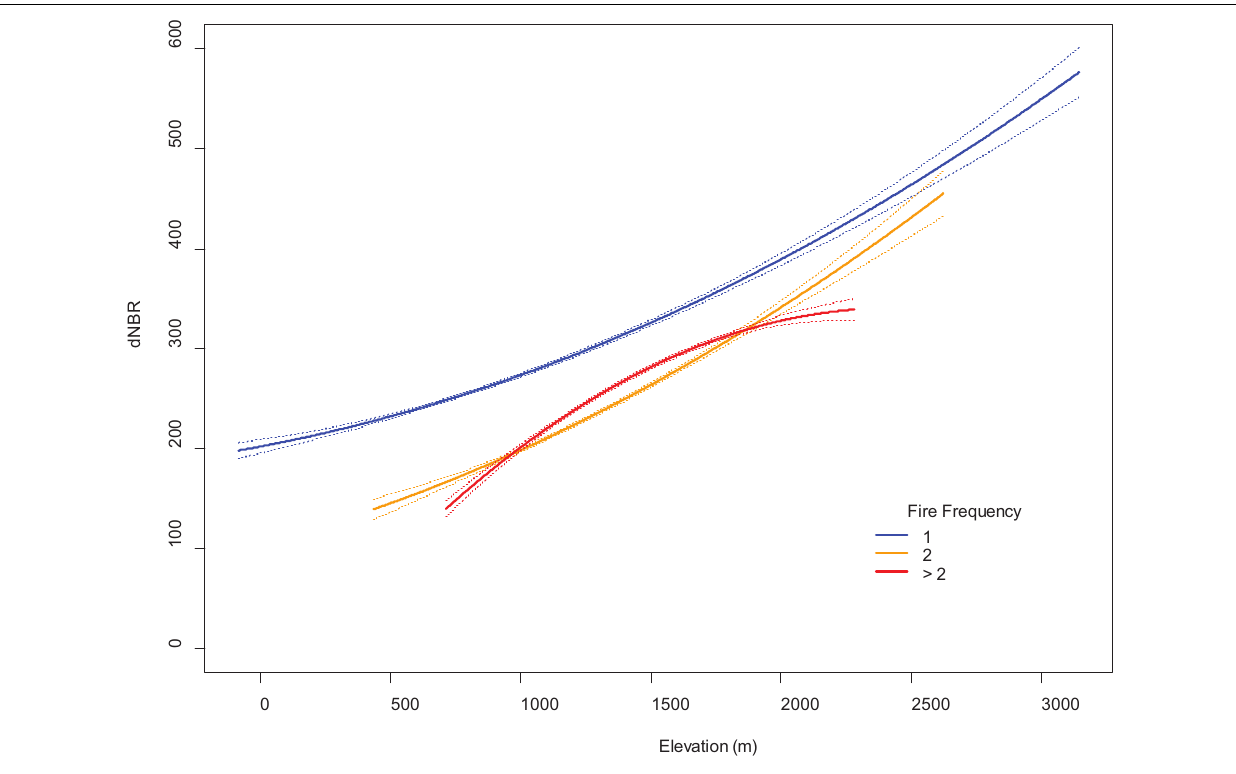
FIGURE 11 | Relationship of predicted values ( ± 95% CI) of burn severity (difference normalized burn ratio; dNBR) and fire frequency (number of times burned from 1972 to 2010) along an elevation gradient in the Mojave Desert of North America. Estimates were derived by ordinary least-squares regression from 1,000 randomly selected points in each fire frequency